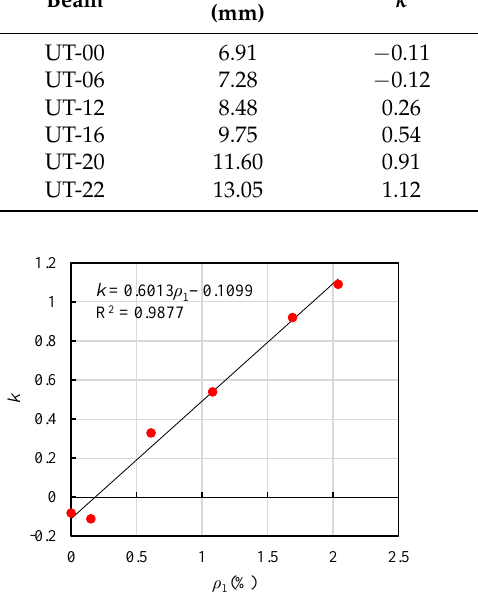
Figure 14. k versus ρ l .